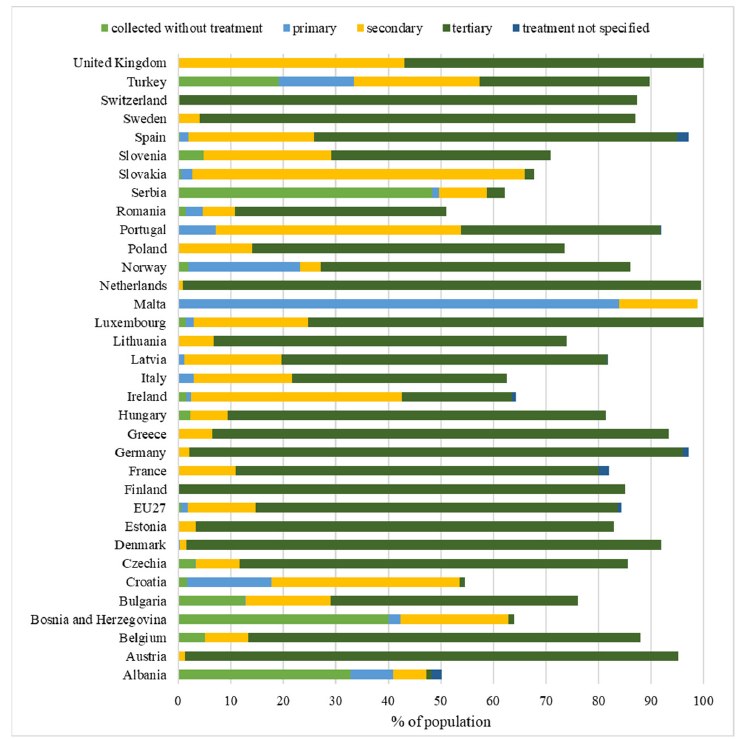
Figure 5. MWW treatment in different European countries in 2017.